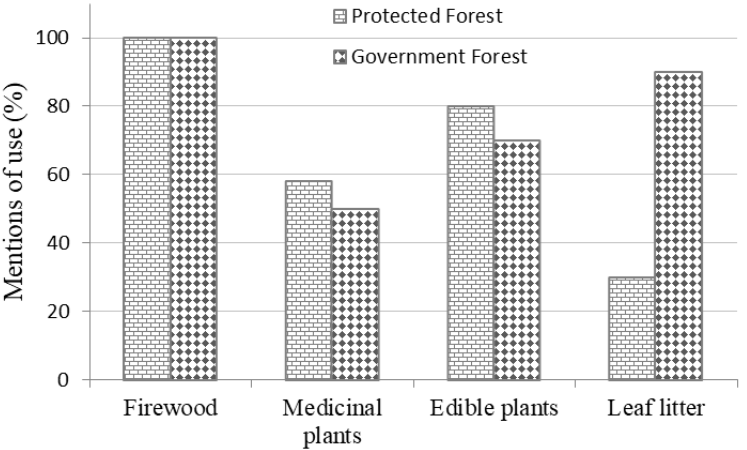
Figure 5. Extraction of forest products from protected forests and government forests, based on household surveys, in the Langtang area of Nepal. Table 6. Oversight over commonly used forest species found in protected forests inside Langtang National Park and in government managed forests outside, based on household interviews conducted at the two sites ( n = 44). Only the five most frequently mentioned species in each category are listed.